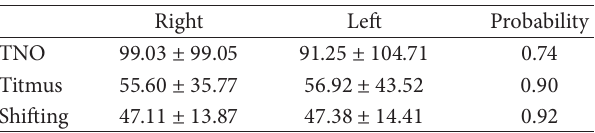
Table 3: Stereopsis scores and shifting amount in Miles test accord- ing to hand